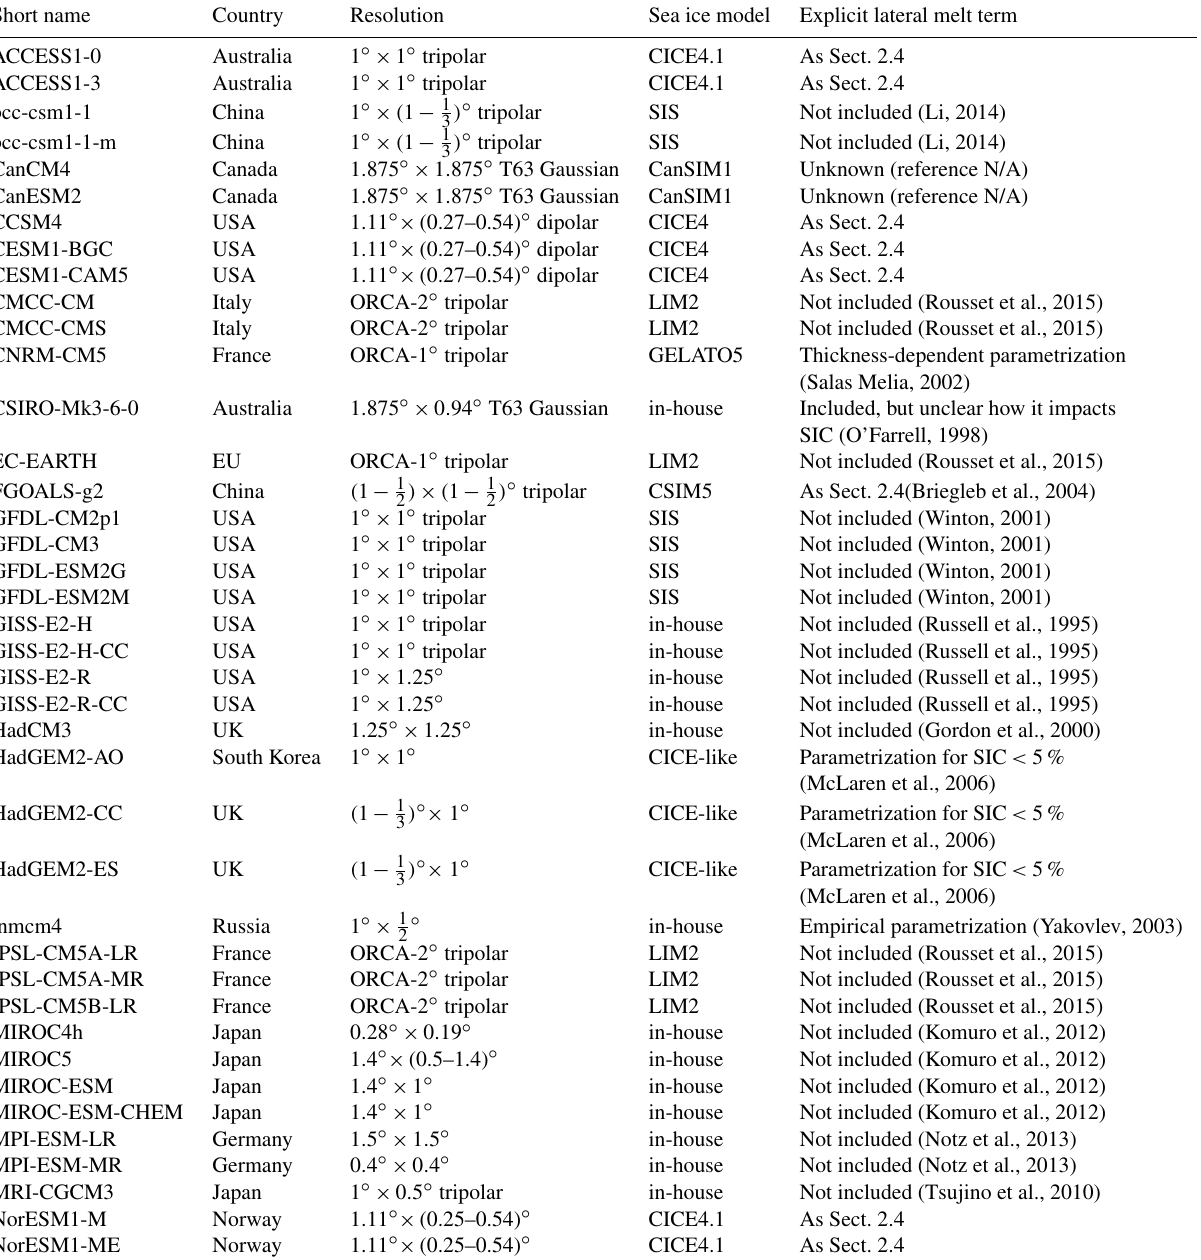
Table 1. CMIP5 models used in this study. SIC denotes sea ice